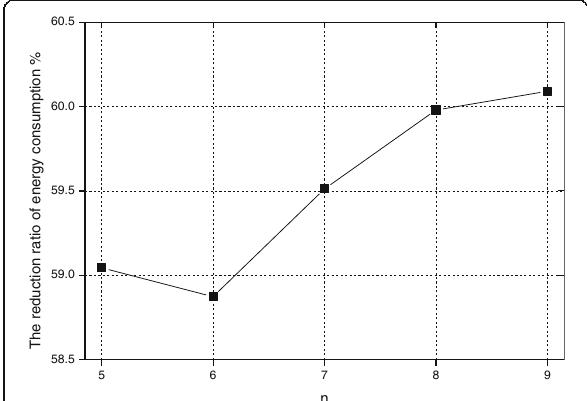
Fig. 28 The optimal duty cycle under UDNP and EDNP